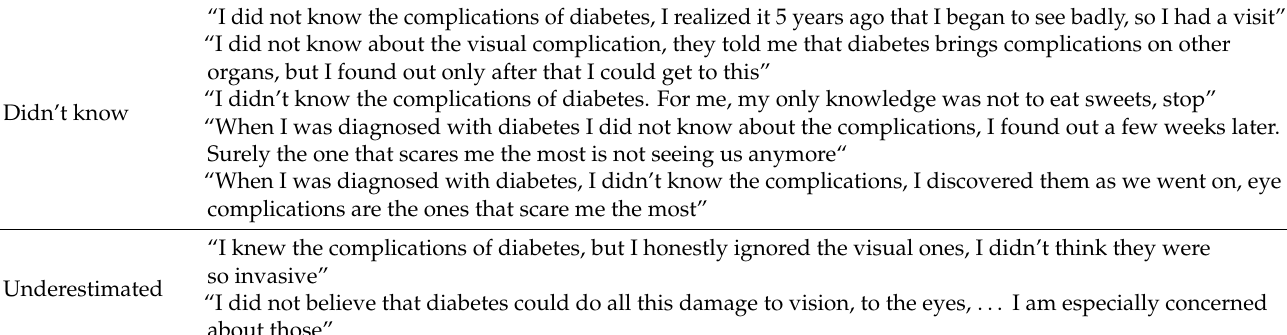
Figure 5. Most feared complications of diabetes. Table 4. Awareness of diabetes complications.